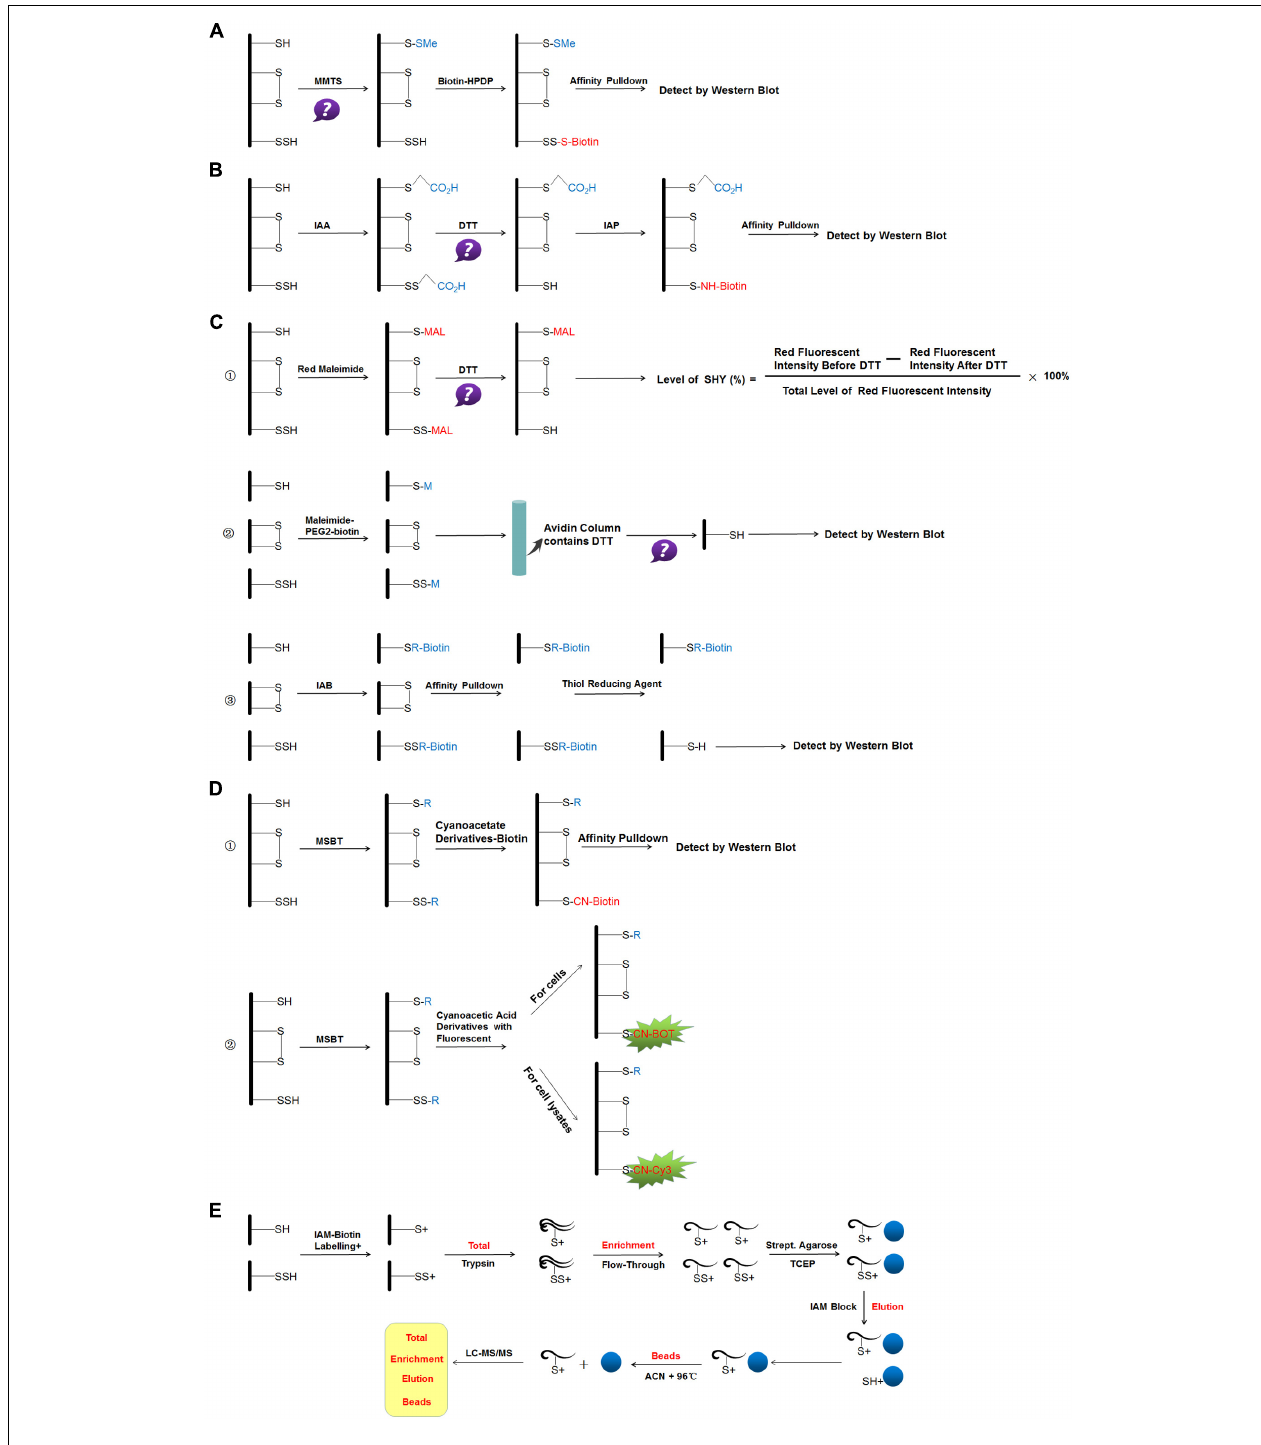
FIGURE 3 | Reaction schemes of different methods for S -sulfhydraion detection. (A) biotin-switch assay; (B) cysteinyl labeling assay; (C) 1 (cid:13) the maleimide assay, 2 (cid:13) improved method of maleimide assay (Biotin-Thiol Assay) and 3 (cid:13) protein persulfide detection protocol (ProPerDP); (D) 1 (cid:13) tag-switch assay and 2 (cid:13) new tag-switch assay; (E) mass spectrometry assay. MMTS: S -methyl methanethiosulfonate, Biotin-HPDP: N -[6-(biotinamido)hexyl]-3 (cid:48) -(2 (cid:48) -pyridyldithio) propinamide, IAA, Iodoacetic acid; DTT, dithiothreitol; IAP, Iodoacetamide-linked biotin; IAB, Iodoacetyl-PEG 2 -Biotin; MSBT, methylsulfonyl benzothiazole; CN-BOT, Cyanoacetic acid derivatives with the fluorescent BODIPY moiety; CN-Cy3, Cyanoacetic acid derivatives with the fluorescent Cy3-dye; IAM-Biotin, Iodoacetyl-PEG2-Biotin; TCEP, Tris(2-carboxyethyl)phosphine; IAM, Iodoacetamide; ACN, Acetonitrile; LC-MS/MS, Liquid chromatography and mass spectrometry.